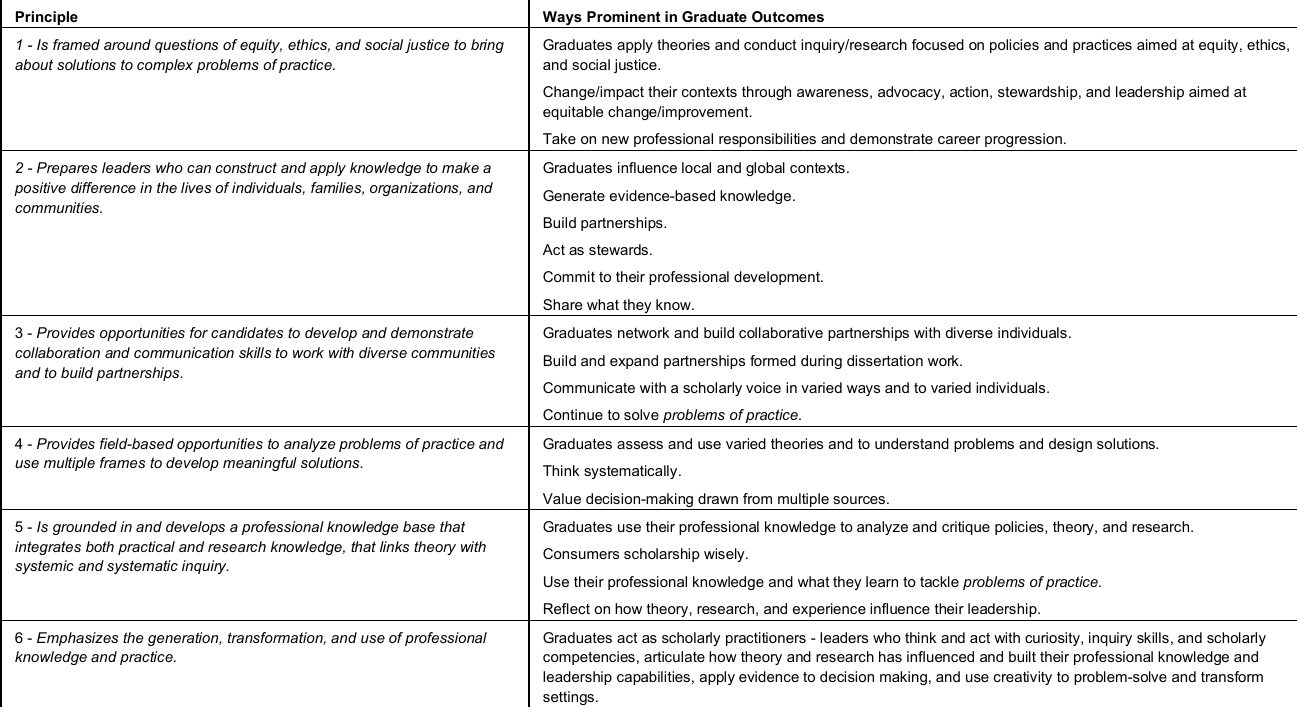
Table 3. The Principles in Graduate Outcomes Principle Ways Prominent in Graduate